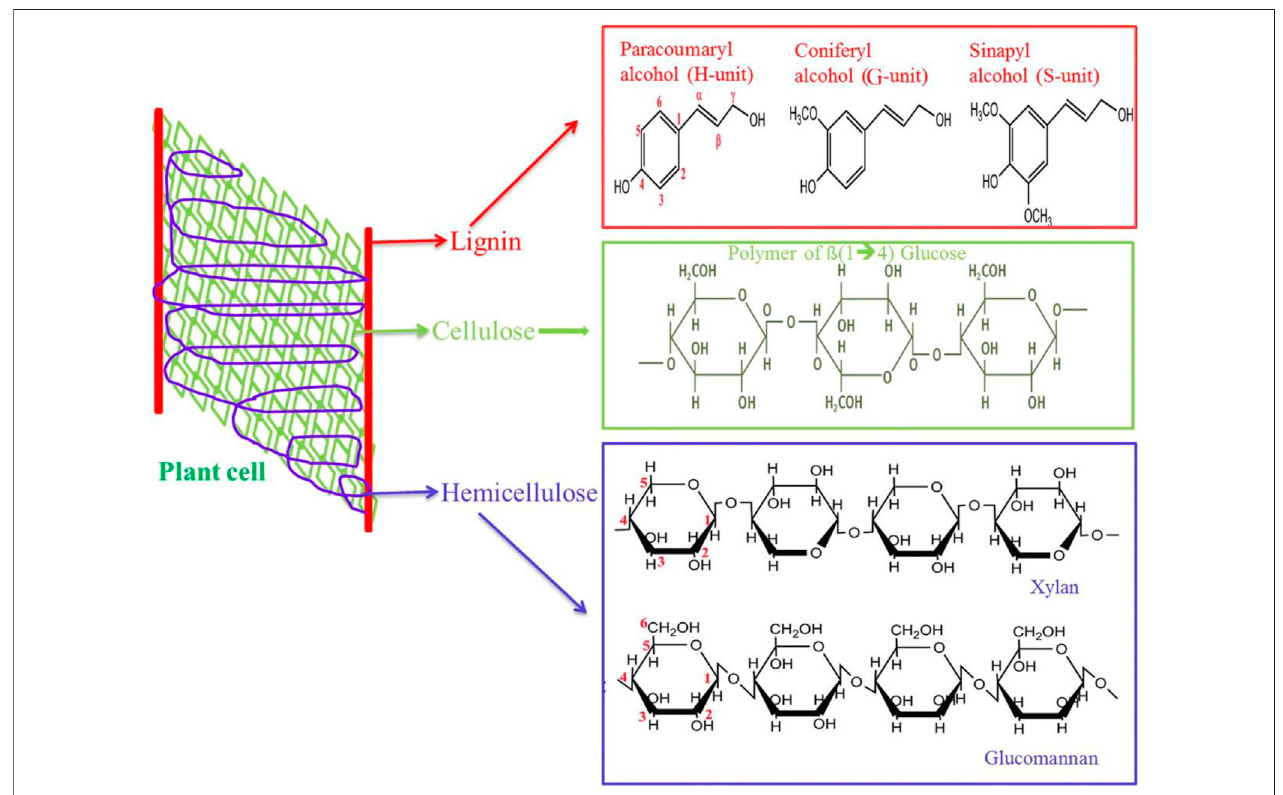
FIGURE 2 | Structural arrangement of straw biomass. Reproduced with permission from Machineni et al. (2019).